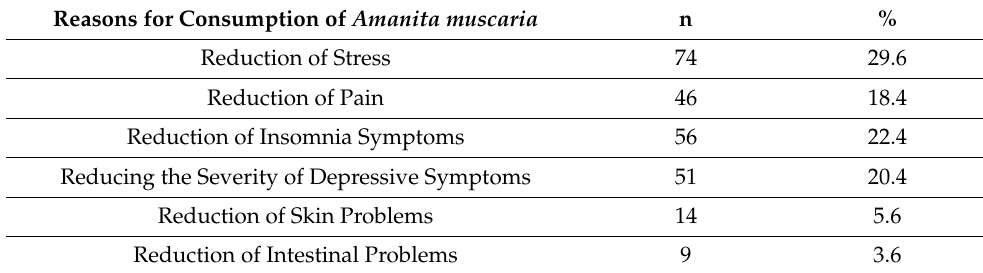
Table 1. Reasons for consumption of Amanita muscaria in the study group. Reasons for Consumption of Amanita